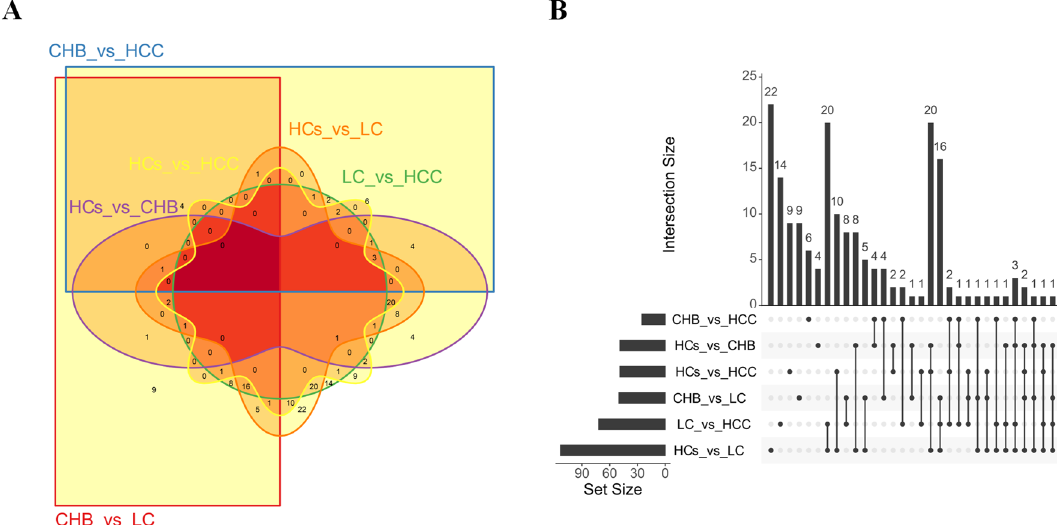
Figure 2. A Venn diagram showing pairwise comparison of differentially expressed proteins between patients with chronic HBV infection (CHB), liver cirrhosis (LC), and hepatocellular carcinoma (HCC) and healthy controls (HCs). ( A ) The Venn diagram was drawn by the R package Vennerable. For convenience of description, CHB, LC, HCC, and HCs groups are denoted by CHB, LC, HCC, and HCs, respectively. ( B ) An UpSet diagram showing pairwise comparison of differentially expressed proteins between CHB, LC, HCC, and HCs. The UpSet diagram was drawn by the R package UpSetR. The figure shows the number of common or unique proteins in different combinations. The lower left corner shows groups with differential expression and the number of different proteins that were screened among each group. The dots on the right show proteins common or specific to the corresponding group. The histogram shows the number of specific or common